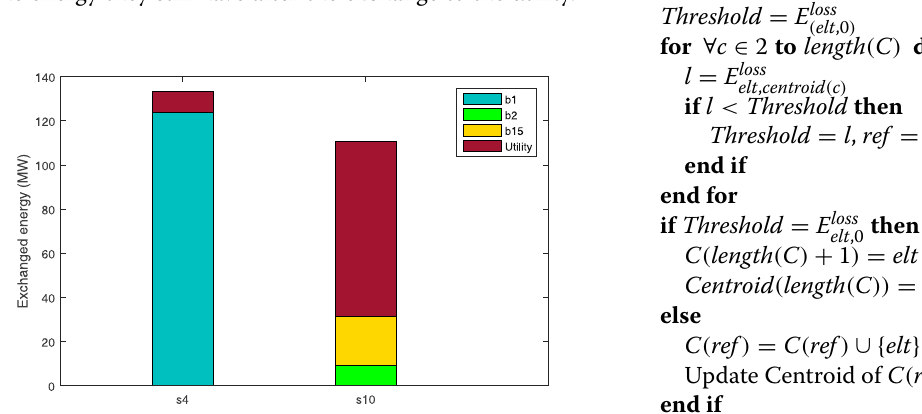
Figure 4 draws a summary of the energy that was exchanged in the given example. b 1 will buy from s 4 all of the energy it needs, b 2 and b 15 will buy all of their energy from s 10 , while both sellers will need to transfer the rest of the energy they still have after the exchange to the utility.